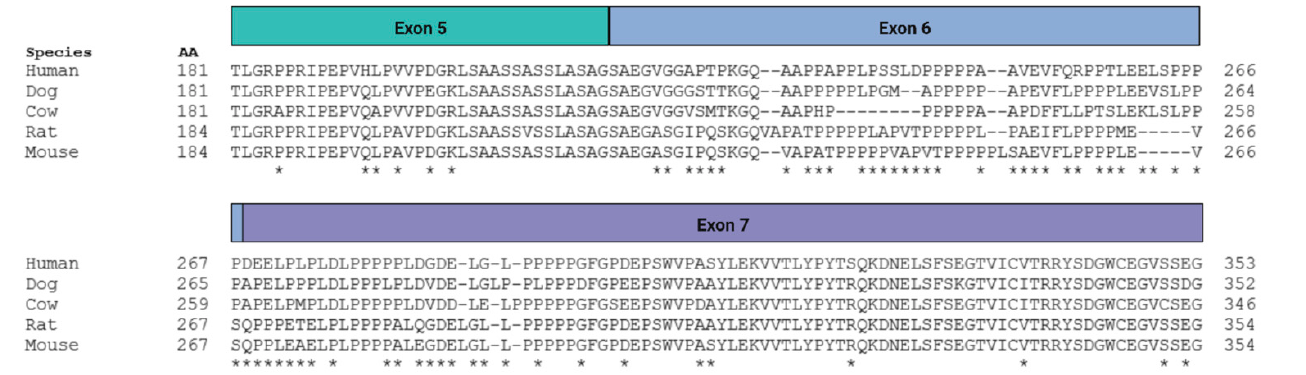
Figure 7. Exon 6 is poorly conserved across mammalian species . The prototypic ABI3 amino acid sequence from exons 5 to 7 was compared to its corresponding sequences in dog ( Canis lupus familiaris ), cow ( Bos taurus ), rat ( Rattus rattus ), and mouse ( Mus musculus ). Mismatches are indicated by asterisks. Note that gaps due to alignment did not count as mismatches unless the other amino acids present also varied. The amino acid sequence encoded by exon 6 was poorly conserved, with many of its amino acids diverging across other mammals.